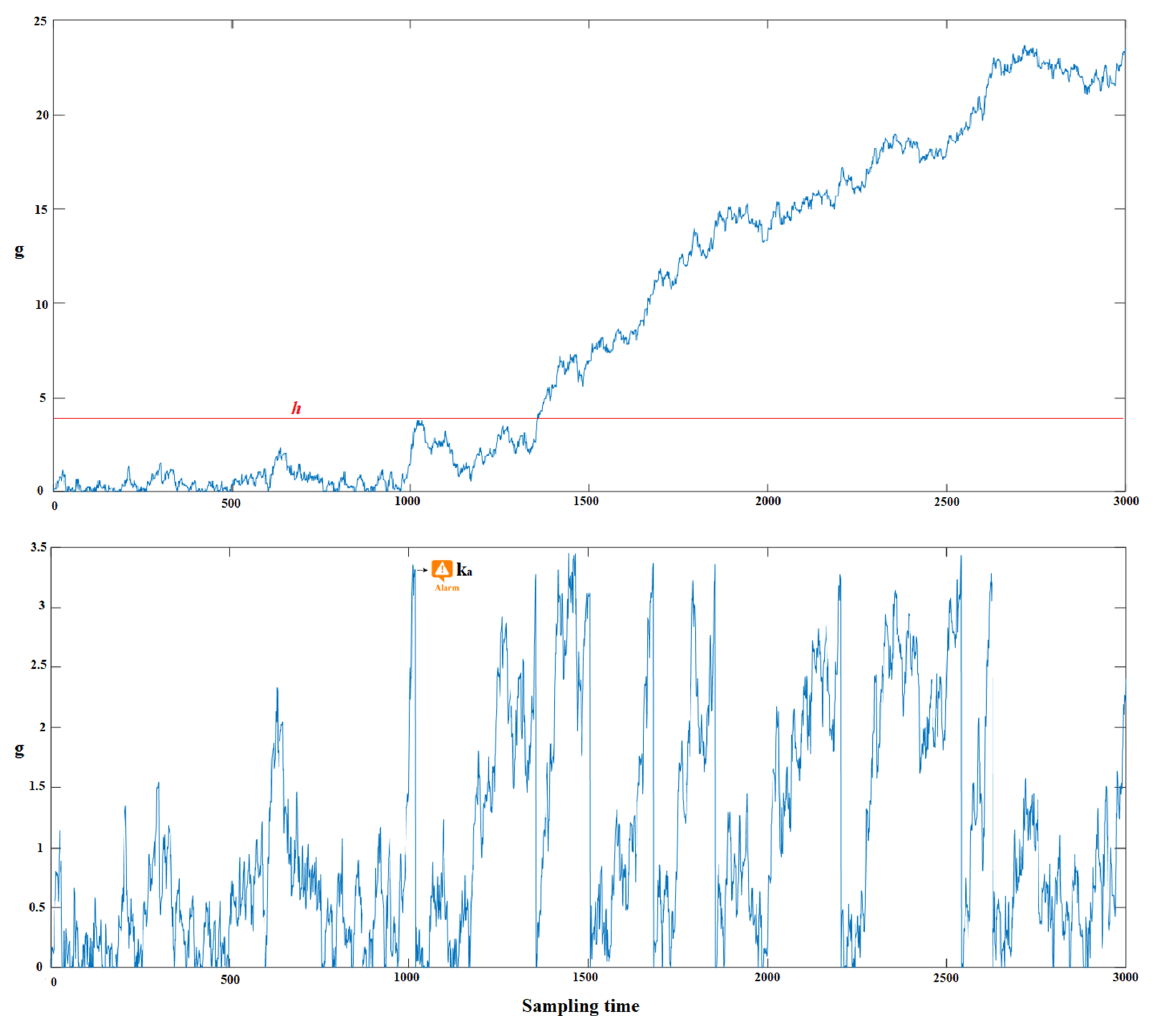
Figure 13. Recursive CUSUM decision function: without re-initialisation (upper chart) and with re-initialisation (lower chart). R-control chart as in Figure 14 is used to simplify the representation of the CUSUM results depicted in Figure 13 (lower chart).